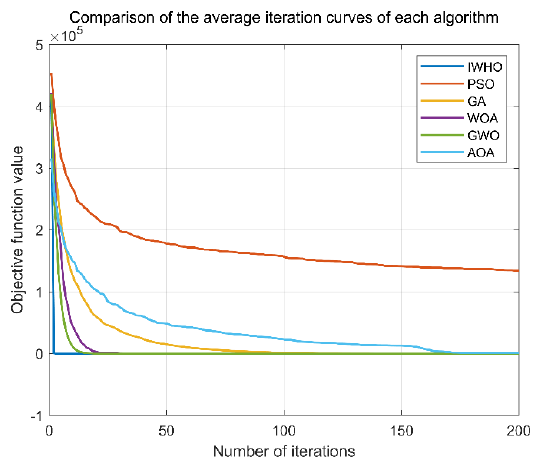
Figure 3. Average objective function convergence curves for each of the six algorithms over 20 runs.